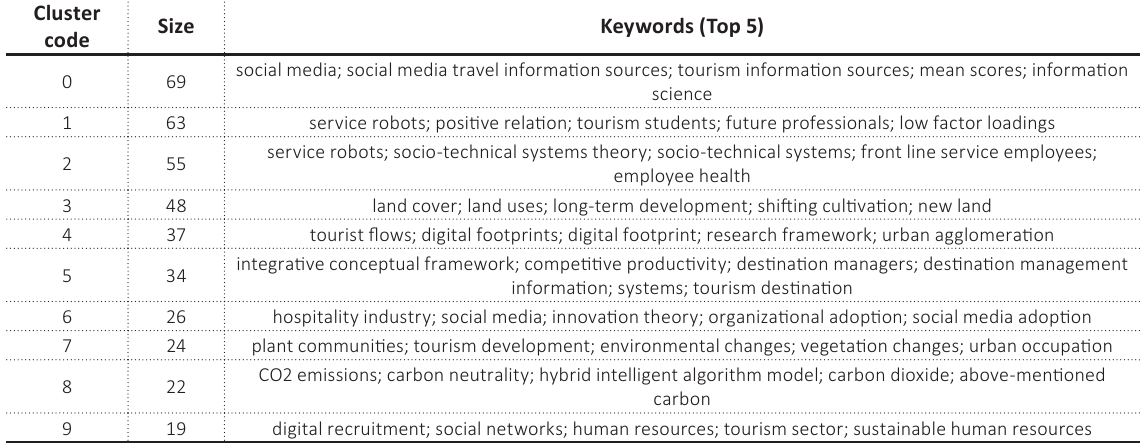
Table 5. Keywords clusters in digital tourism Cluster code